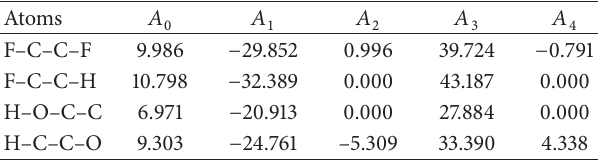
Table 2: The torsional parameters calculated from the ab initio energy profiles for the five-term (𝑁 = 5) truncation of the potential energy function of (2). The coefficients 𝐴 𝑛 have units of